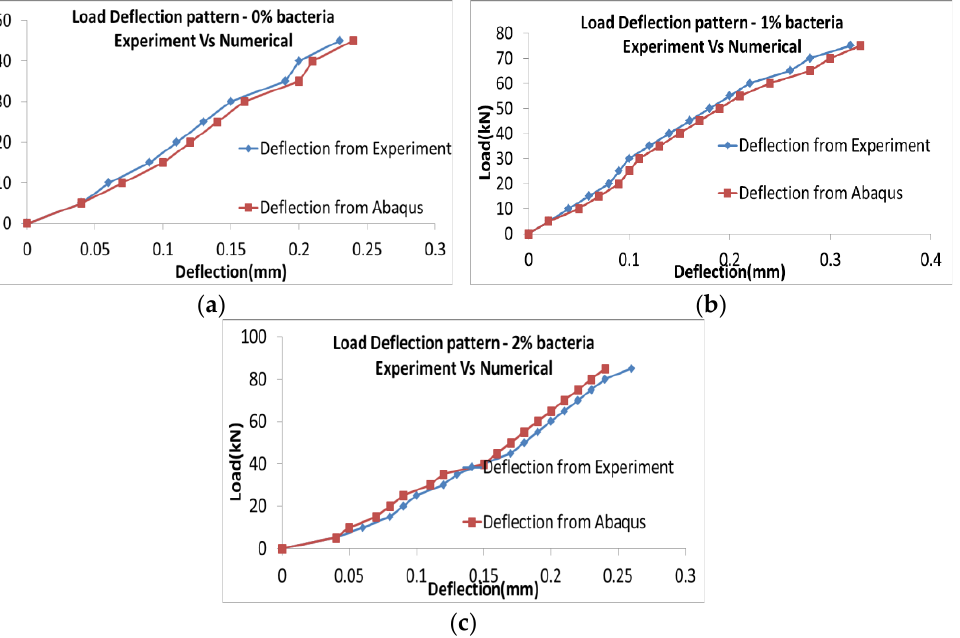
Figure 19. Deflection patterns from ABAQUS. ( a ) 0% bacteria (conventional concrete). ( b ) 75% demolition waste with 1% bacteria. ( c ) 75% copper slag with 2% bacteria. demolition waste with 1% bacteria. ( c ) 75% copper slag with 2%